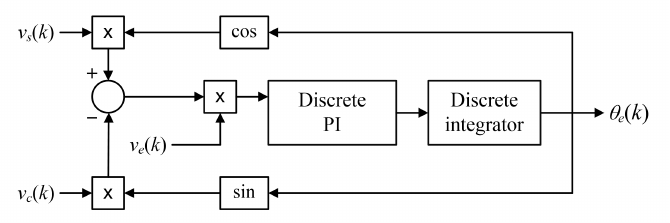
Figure 8. PI-based